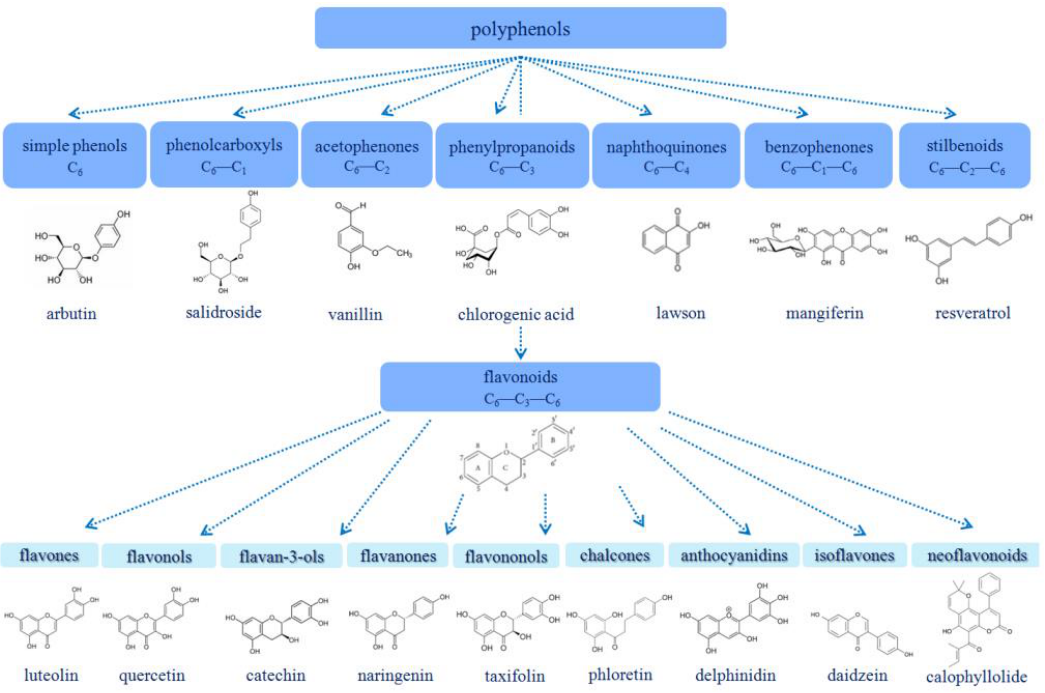
Figure 1. The classification of plant polyphenols and the chemical structures of some representa- tives.